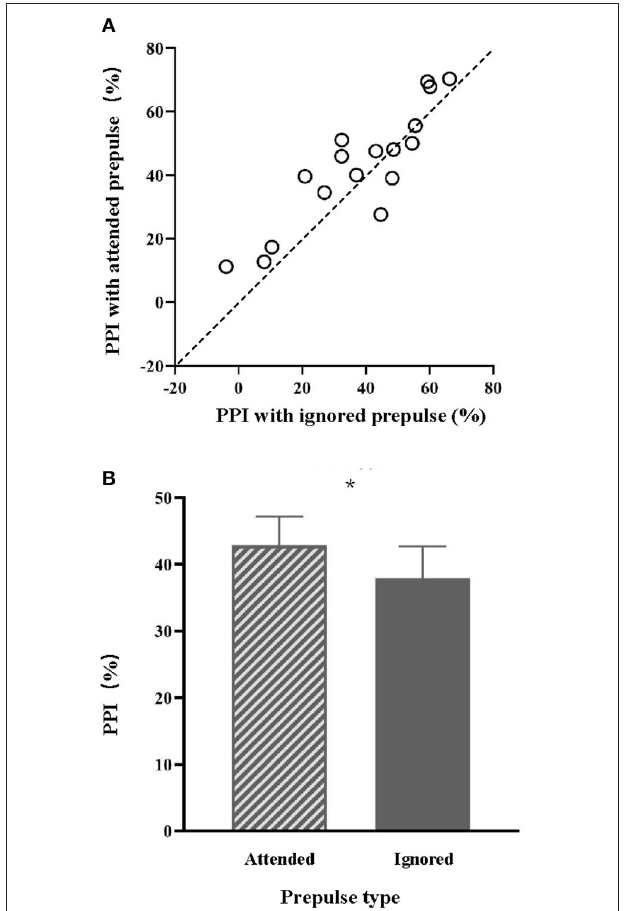
FIGURE 1 | (A) The PPI values with the attended prepulse or with the ignored prepulse for the 17 individuals in Experiment 1. (B) Comparisons of the mean PPI magnitude between the attended prepulse condition and the ignored prepulse condition. * p <